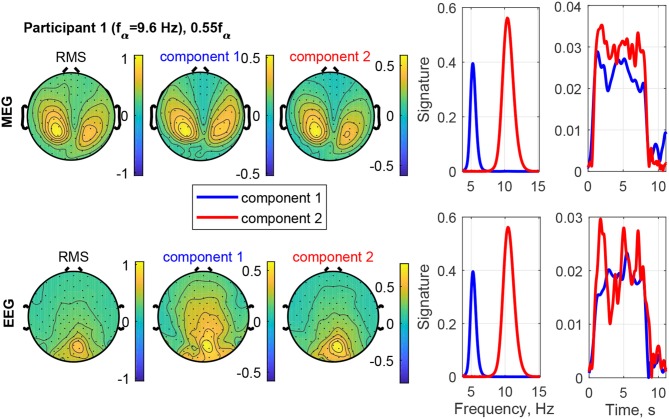
RMS, channel, frequency, and time signature for Participant 1 and stimulation frequency 0.55fα.